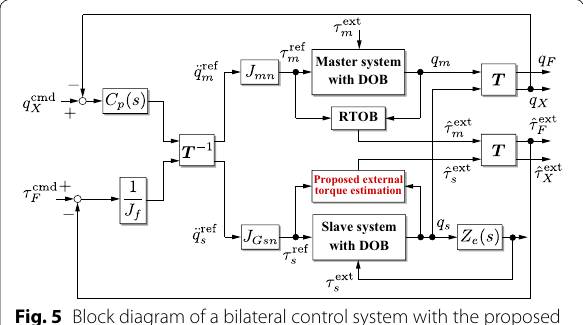
Fig. 5 Block diagram of a bilateral control system with the proposed external force estimation